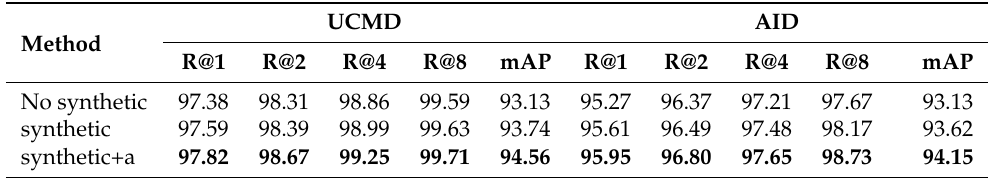
Table 3. Validation of the sample synthetic method on UCMD and AID. The best results are shown in bold.